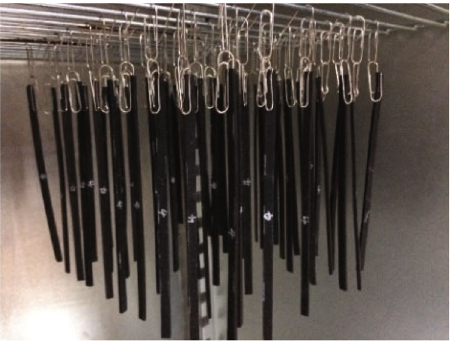
Fig. 10 The specimens in the aging oven. Vulcanizate strips are hung dispersedly in the temperature-controlled air-aging oven to ensure uniformly